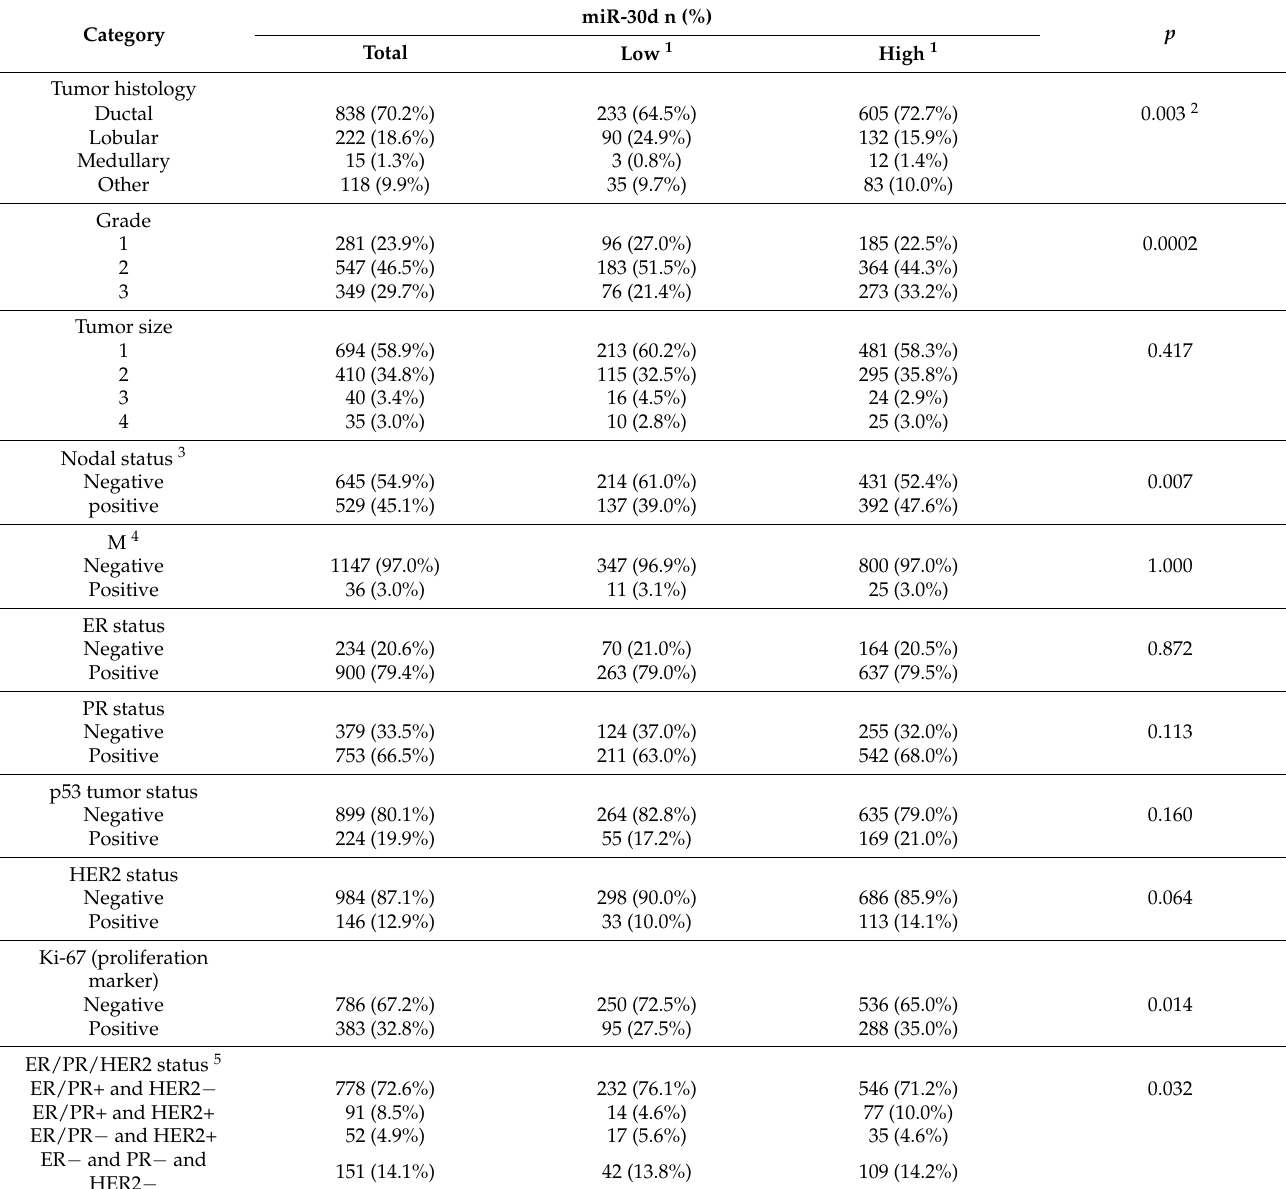
Table 1. Association of miR-30d expression with the clinical and pathological features of the